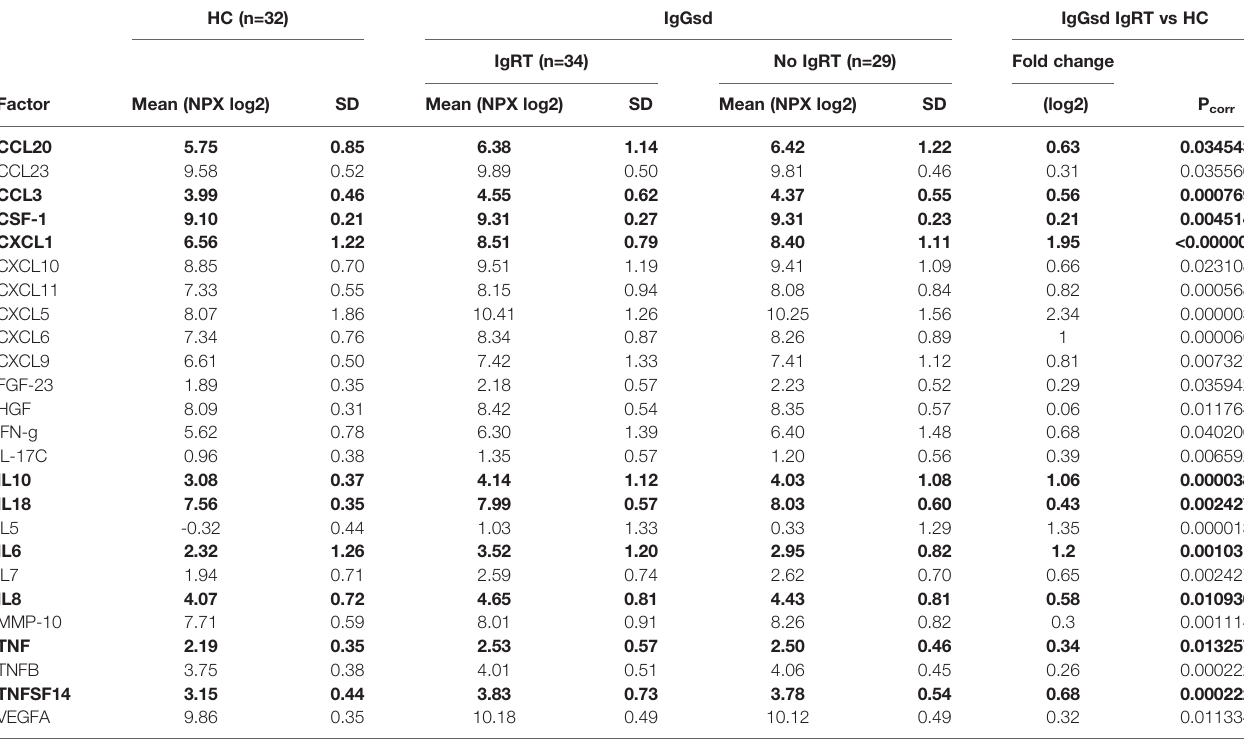
Factors in bold are associated with IL-10 signalling. NPX, normalized protein expression in Log 2 scale; HC, healthy controls; IgGsd, immunoglobulin subclass de fi ciency; IgRT, immunoglobulin replacement therapy; SD, standard deviation; P corr , t-test p-value with Benjamin-Hochberg correction for multiple